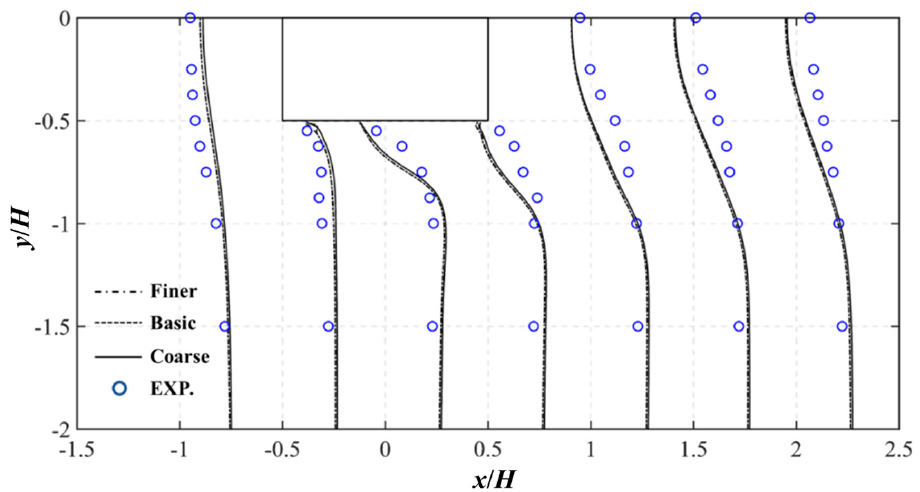
Figure 6. Streamwise velocity along seven horizontal lines at a horizontal section.